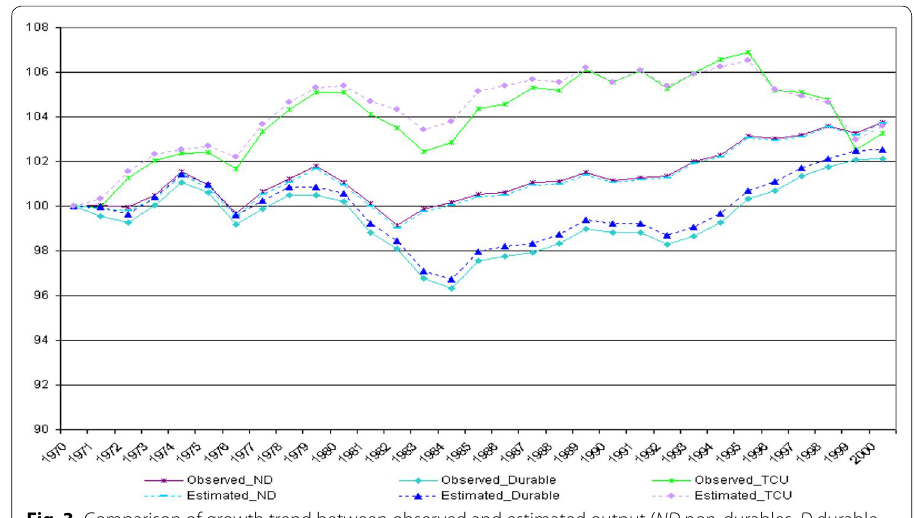
Fig. 3 Comparison of growth trend between observed and estimated output ( ND non-durables, D durable, TCU transportation, communications and utilities sector, 1970